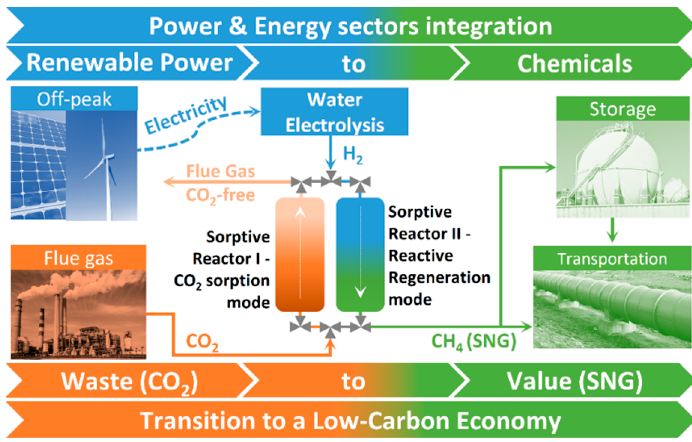
Figure 1. Power-to-gas concept: system boundaries with a cyclic sorption-reaction process for CO 2 capture and conversion/utilization. Reprinted from Chemical Engineering Journal, 322, C.V. Miguel,